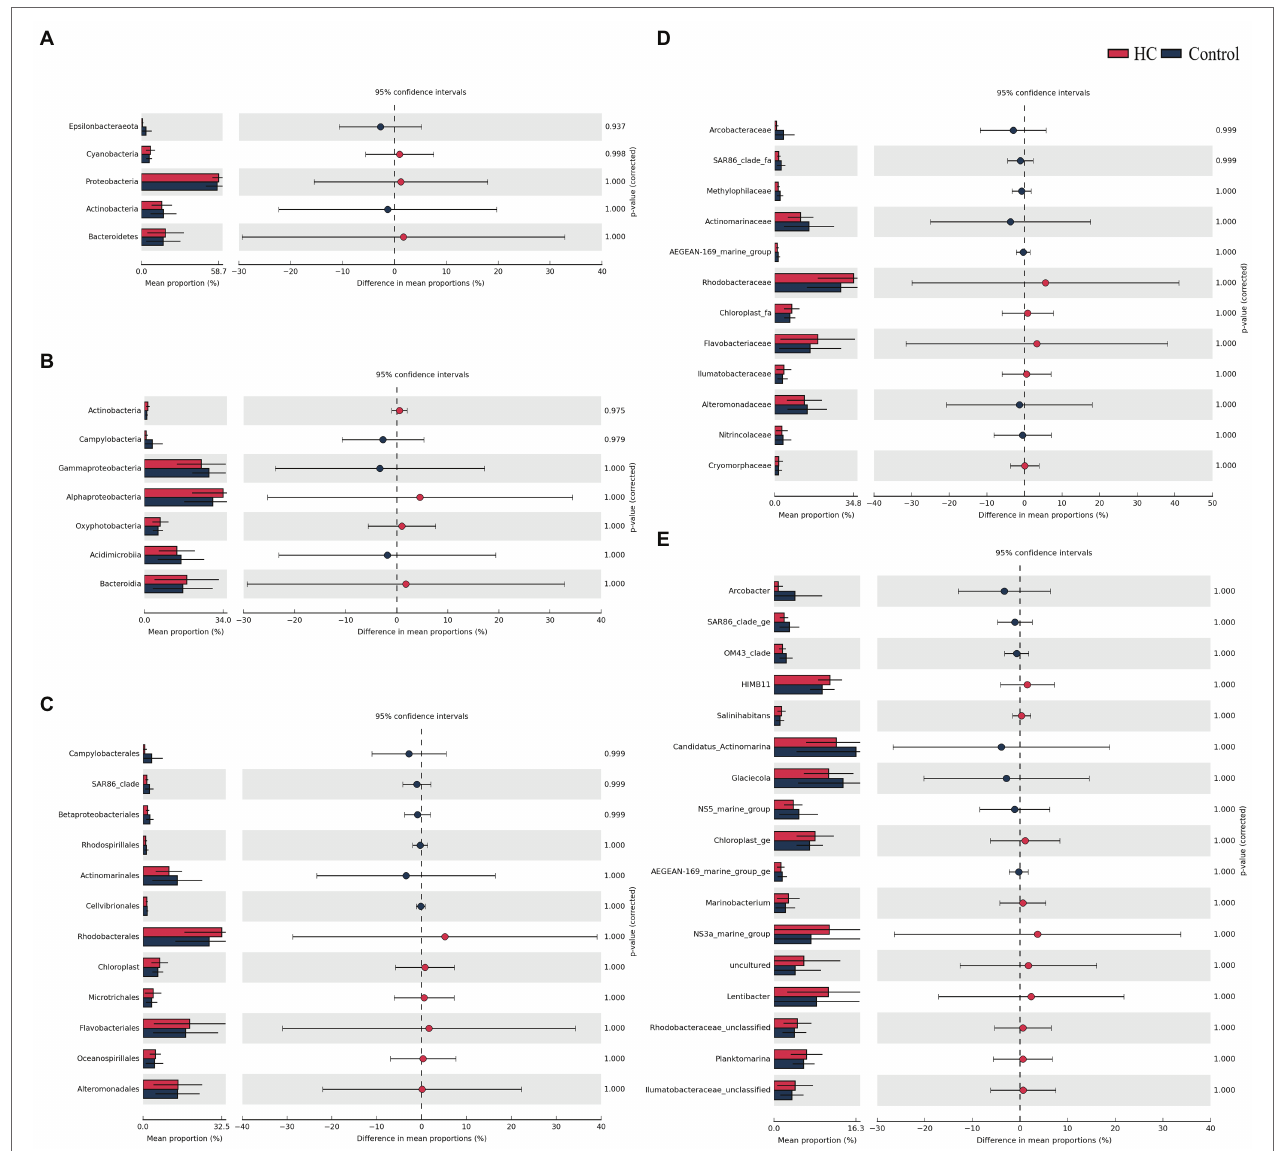
FIGURE 6 | STAMP analysis of relative abundance of bacterioplankton communities at the phylum (A) , class (B) , order (C) , family (D), and genus (E) levels between elevated p CO 2 (HC, about 1,000 μ atm) and ambient p CO 2 (Control) conditions.